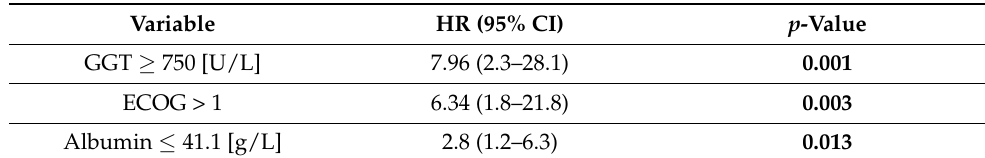
Table 3. Results from multivariable Cox regression after stepwise inclusion of candidate variables. Significant results are printed in bold.